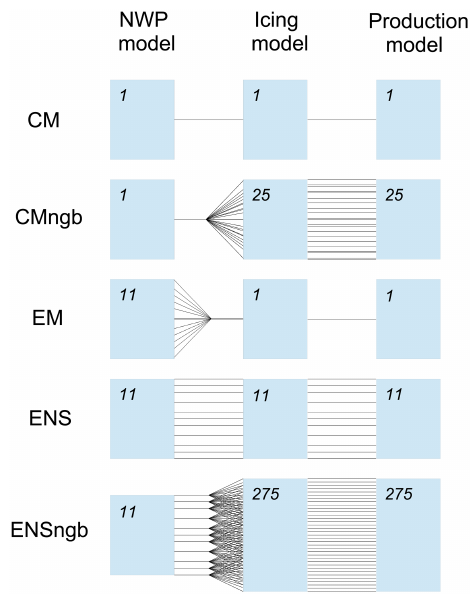
Figure 3. Uncertainty quantification approaches. The commonly used approach CM and the four uncertainty quantification ap- proaches. CM: control member, a single forecast used in each fore- cast step. CMngb: control member together with the neighbourhood method. EM: ensemble mean, averaging the ensemble members after the first modelling step. ENS: ensemble, using all ensemble members throughout all modelling steps. ENSngb: ensemble to- gether with the neighbourhood method. The number in each box represents the number of forecast members in each forecast